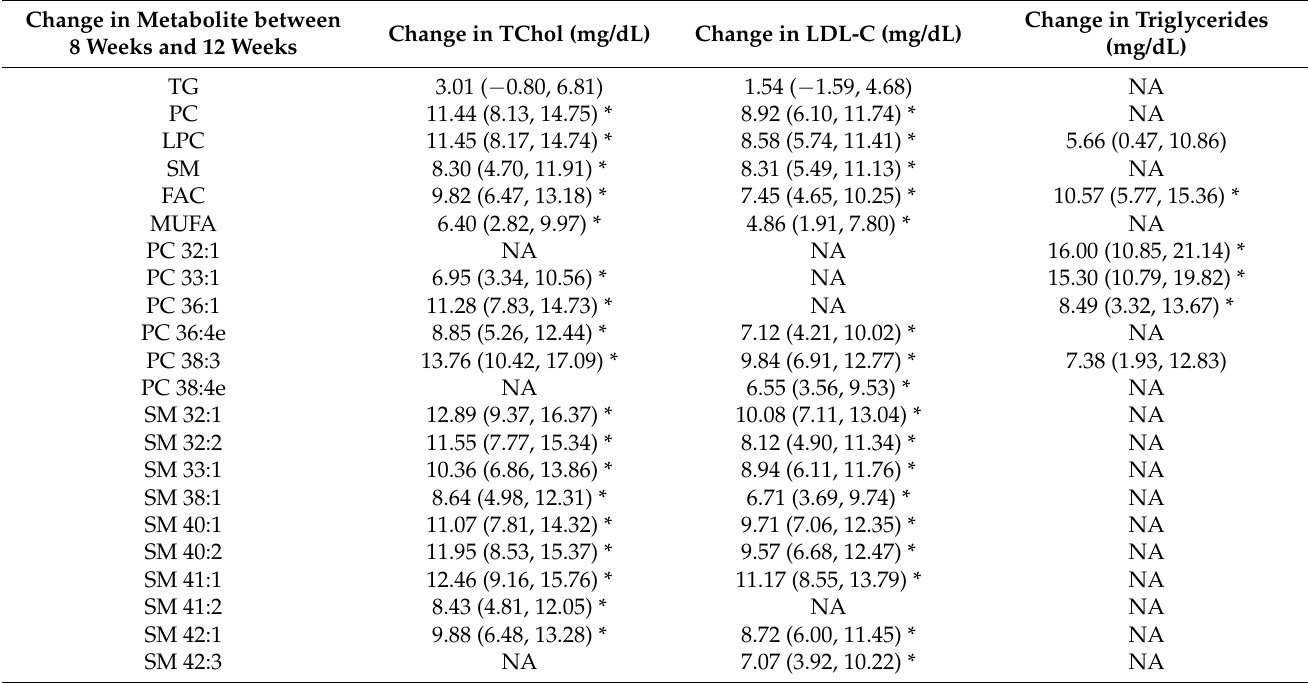
Table 3. Changes in cardiovascular parameters after the 12-week weight loss maintenance period per 1SD log-transformed changes in the concentrations of